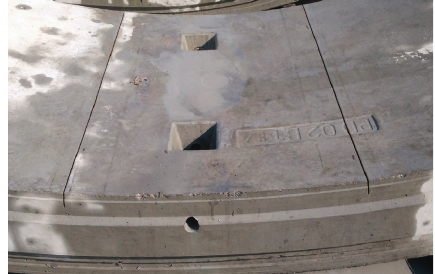
Figure 5: Measuring concrete strain using strain gauge.